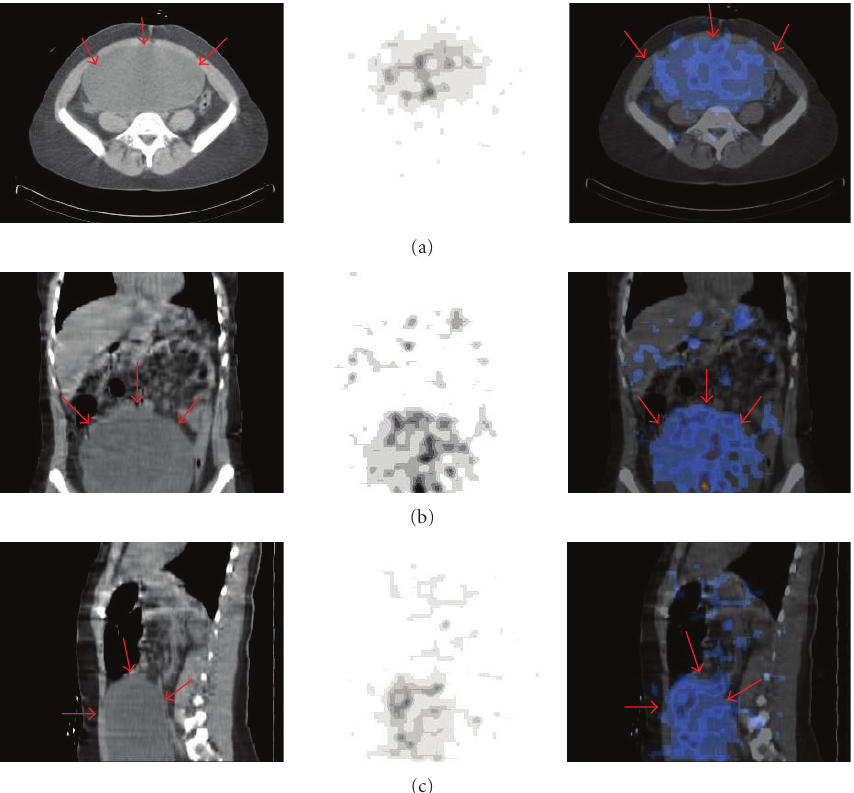
Figure 2: Abdominal SPECT-CT image (left, CT; middle, SPECT; right, 131 I-SPECT/CT) revealed a very large abdominal mass with radioiodine accumulation in the transaxial (a) coronal (b), and sagittal (c) images. Note the heterogeneous distribution of radioiodine throughout the tumour